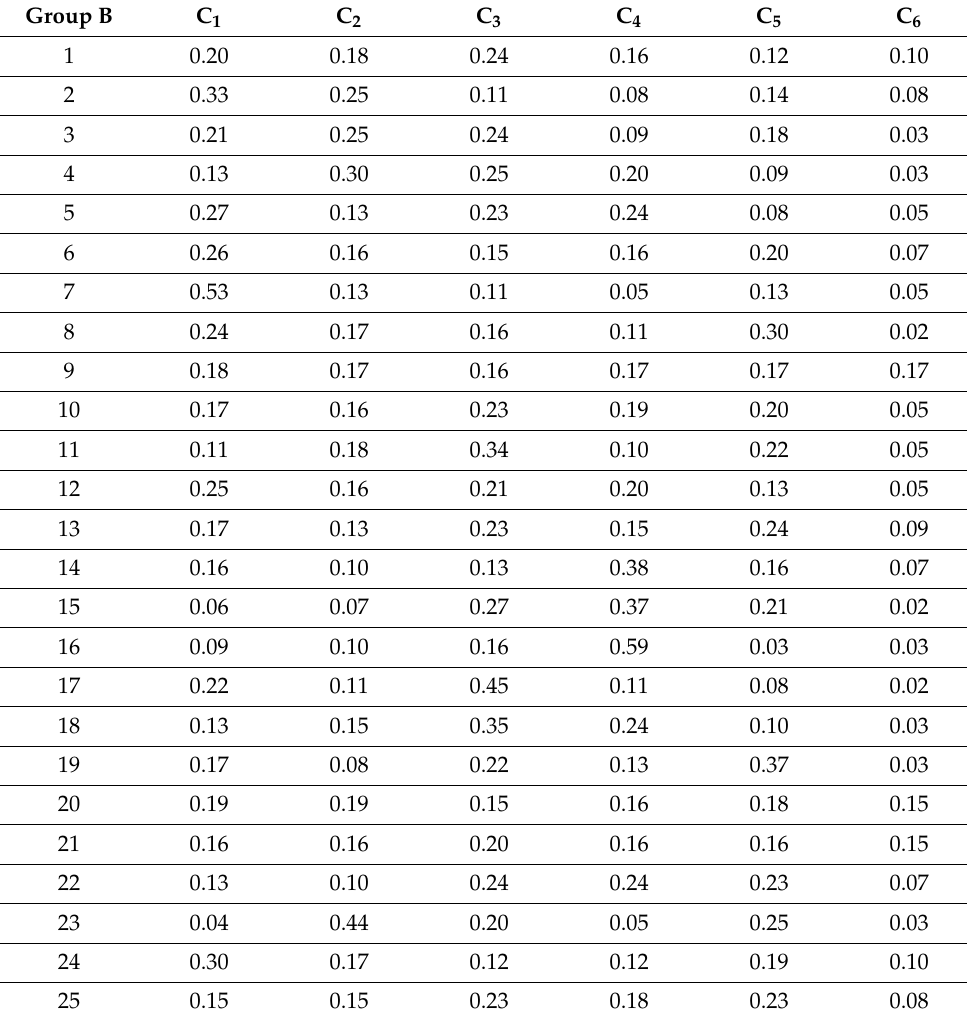
Table A2. Individual priorities for each participant in group